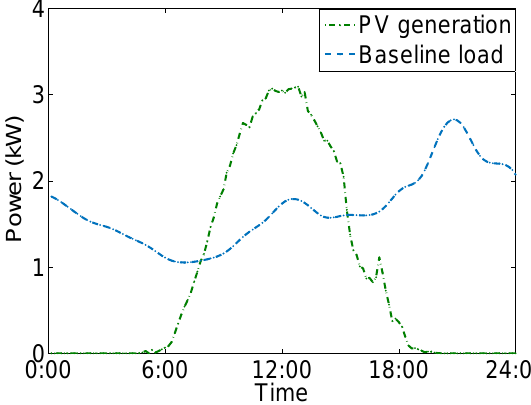
Figure 3. PV generation and baseline load of households.